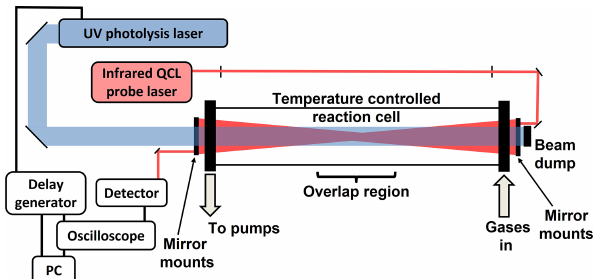
Figure 1. Schematic of the experimental apparatus. The probe beam passes through the reaction cell multiple times, with mirrors in a circular arrangement on the mounts positioned at each end of the cell such that the probe passes from the top of the cell to the bottom or from left to right in any individual pass through the cell, resulting in the overlap between the photolysis and probe beams occurring in the centre of the cell.